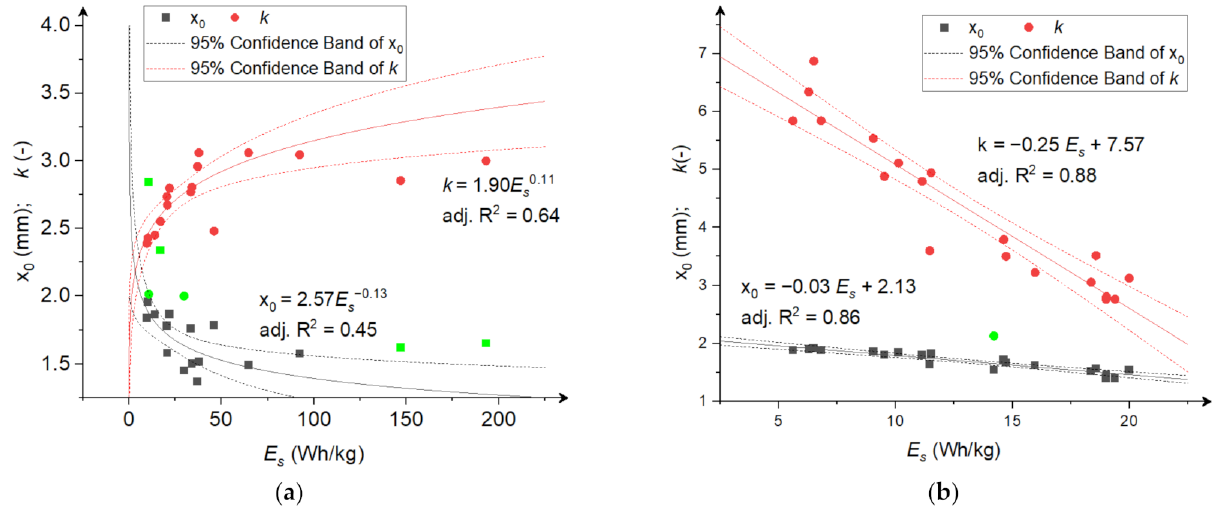
Figure 8. The dependence between RRSB distribution parameters and specific comminution energy; ( a ) corn grains; ( b ) rice grains. The green points are outliers not included in the